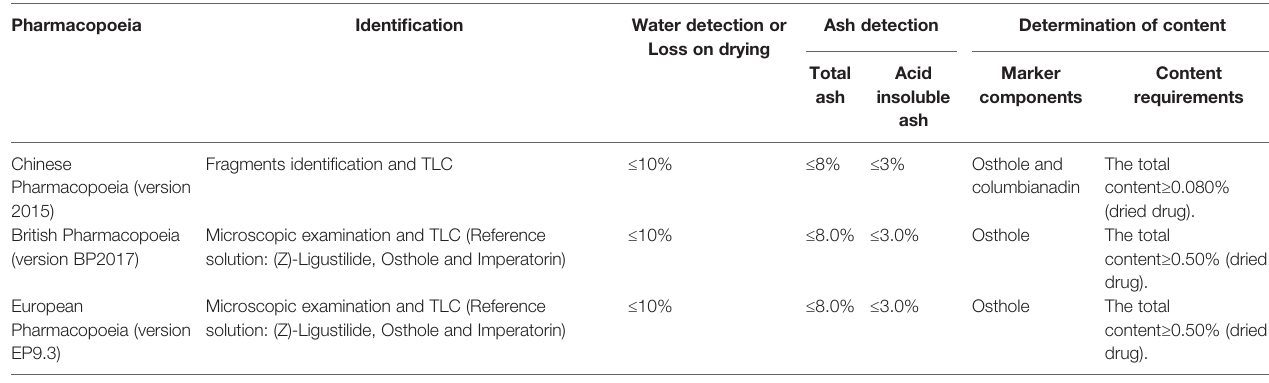
TABLE 5 | Quality control items for APR in multi-national